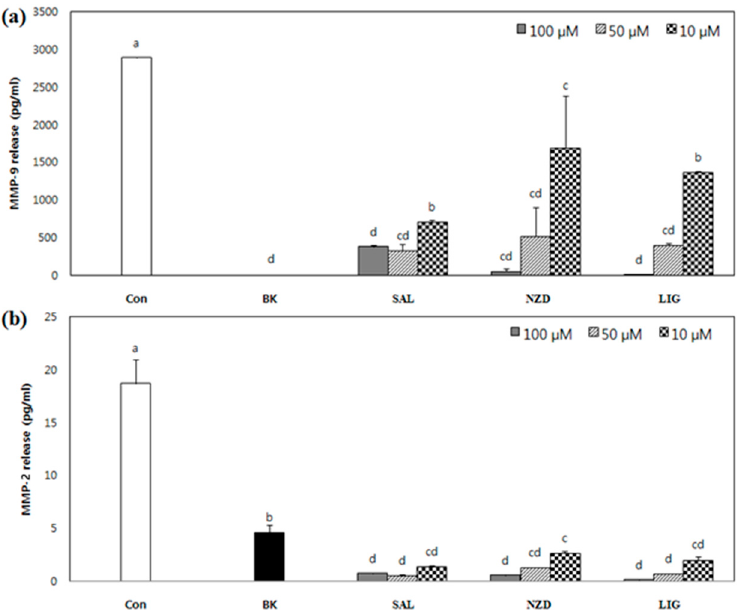
Figure 4. Released amounts of MMP-9 ( a ) and MMP-2 ( b ) by PMA-stimulated HT1080 cells treated with or without SAL, NZD and LIG at given concentrations (Con: untreated PMA-stimulated cells; BK: untreated unstimulated cells). The culture medium was collected and analyzed for the MMP-2 and -9 levels by ELISA. Data are mean ± SD of three replicates ( n = 3). a-e Means with different letters at the same concentration are significantly different ( p < 0.05), as assessed by Duncan’s multiple range test